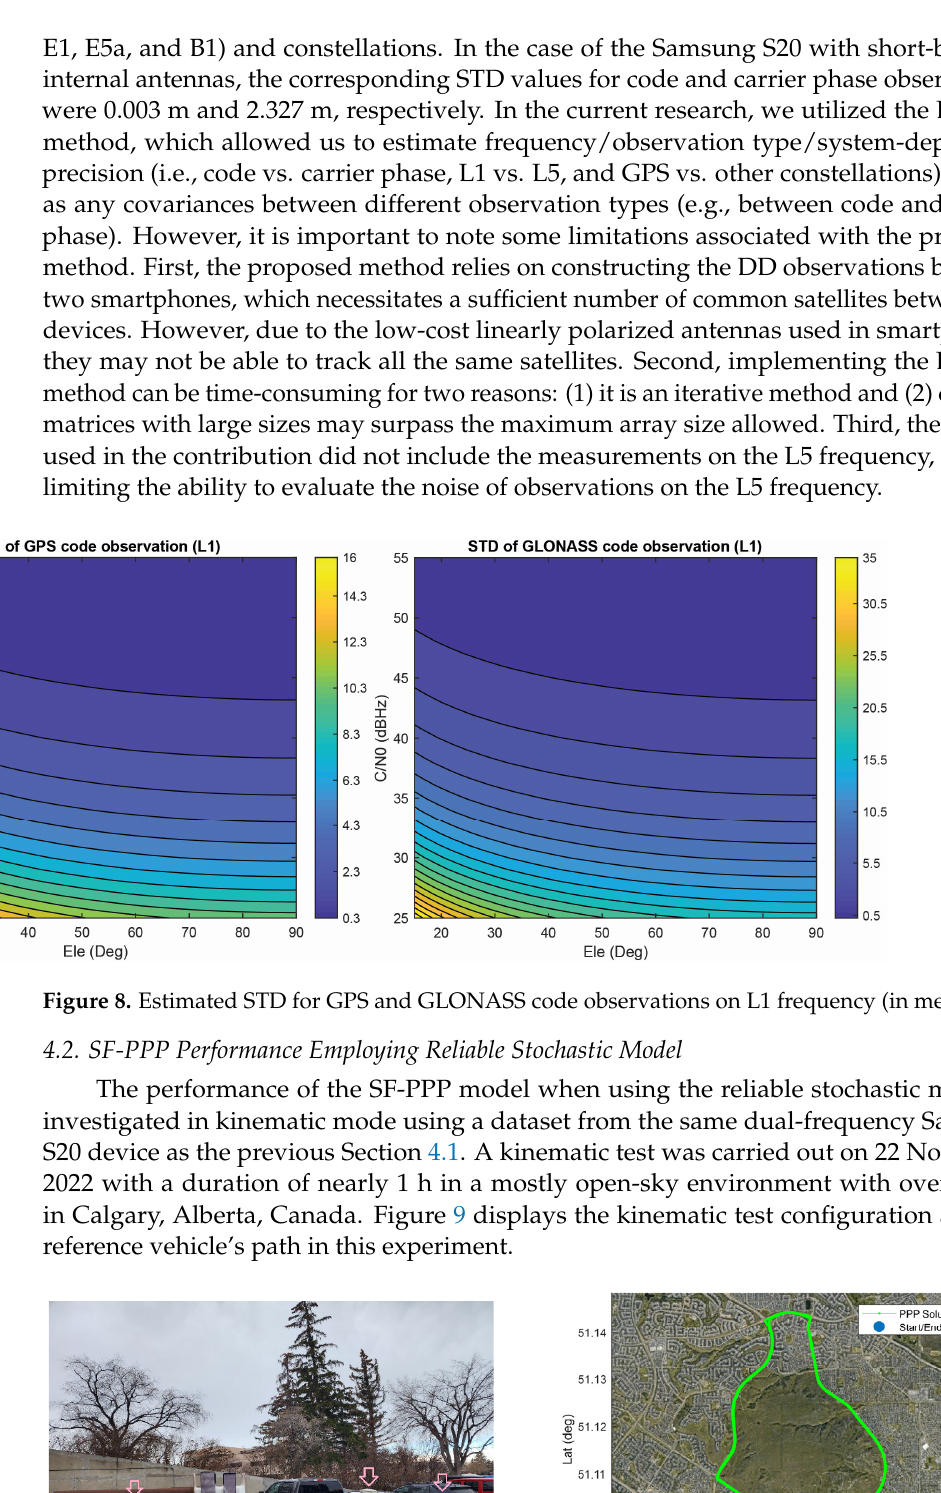
Figure 7. Groupwise estimate of coefficient ( 𝑎 (cid:3047)(cid:3052)(cid:3043)(cid:3032)(cid:3046)(cid:3052)(cid:3046) ; 𝑠𝑦𝑠 : GPS and GLONASS and 𝑡𝑦𝑝𝑒 : code and phase) on L1 frequency as well as correlations among code and phase observations of each constel- lation (i.e., 𝜌 (cid:3008)(cid:3017)(cid:3020) and 𝜌 (cid:3008)(cid:3013)(cid:3016) ).